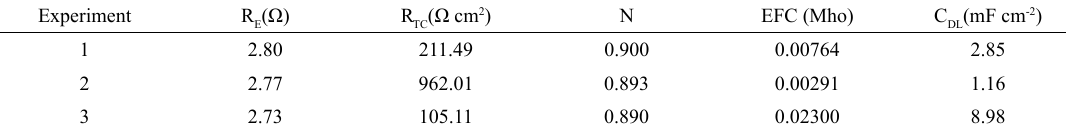
Table 4. Simulated responses for the EIS data using the equivalent circuits of Figure 6